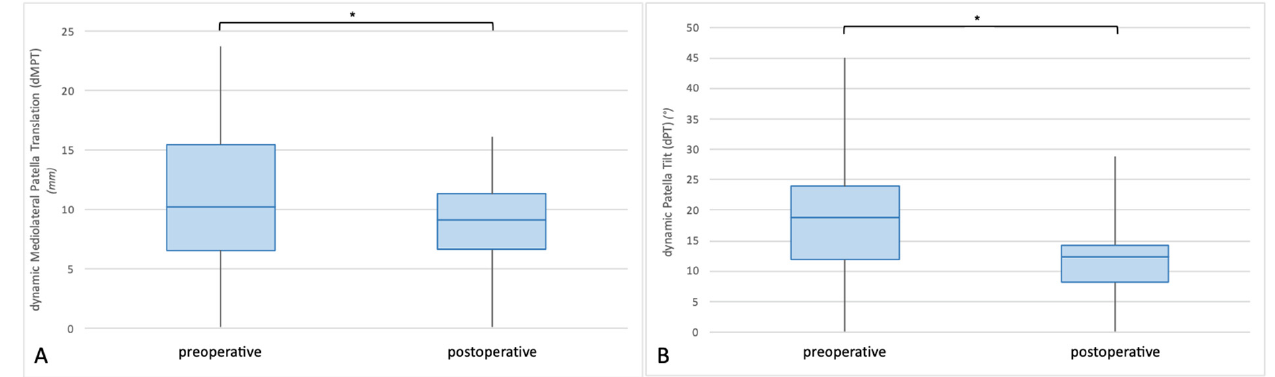
Figure 8. Boxplot illustration of preoperative vs. postoperative dynamic patellar tracking. After surgical realignment, both measurable parameters for dynamic patellar tracking had significantly improved, compared to the preoperative values. The dMPT had decreased from 10.95 ± 5.93 mm to 4.89 ± 0.40 mm ( p < 0.001) ( A ). Accordingly, the dPT had changed from 14.50 ± 10.33 ◦ preoperatively to 8.44 ± 7.46 ◦ postoperatively ( p = 0.026) ( B